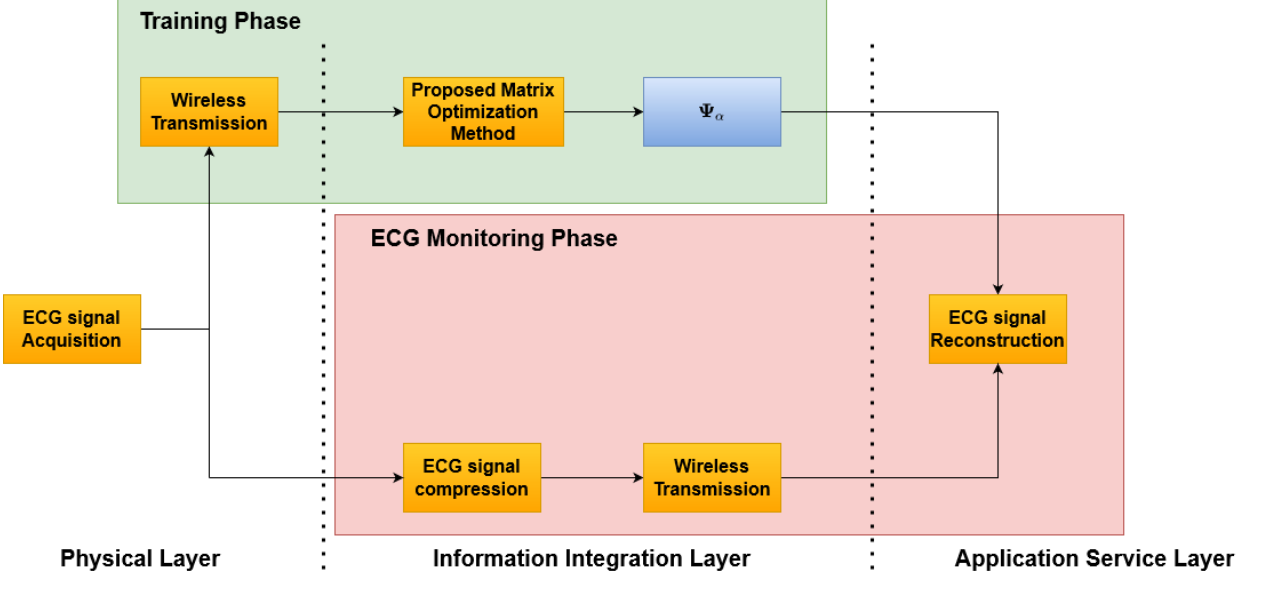
Figure 1. Block scheme of the Proposed Method.